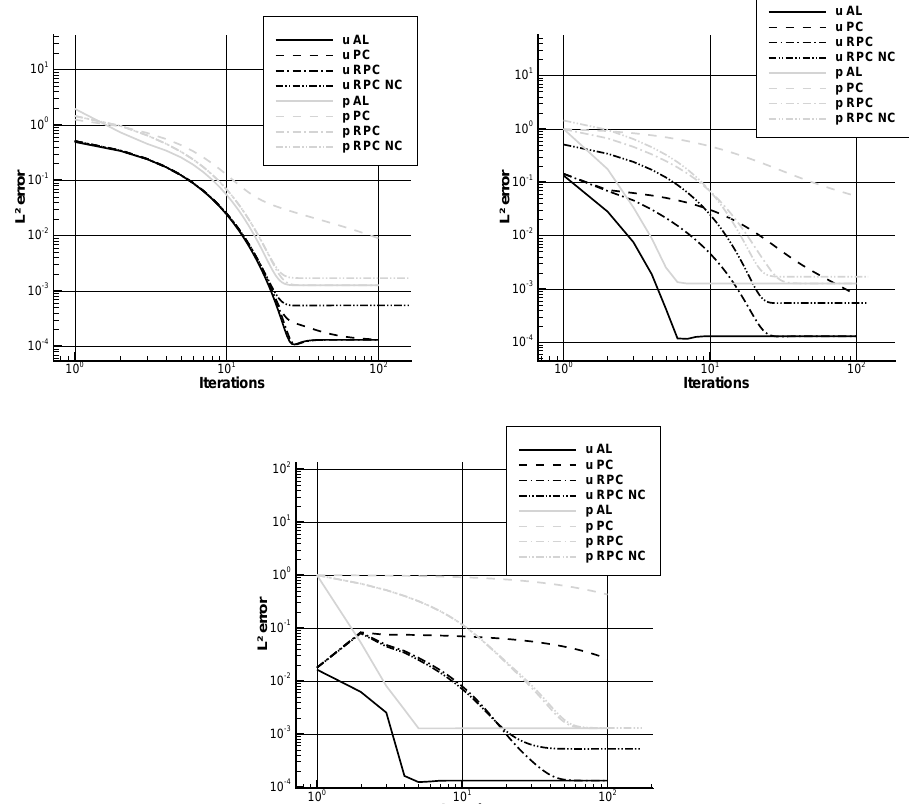
Figure 4. Evolution of the L 2 -norm of the spatial error for ∆ t = 0.1 s, ∆ t = 1 s, and ∆ t = 10 s for the Couette flow for the augmented Lagrangian (AL), the incremental pressure-correction (PC), the rotational pressure-correction (RPC), and the uncorrected the rotational pressure-correction (RPC